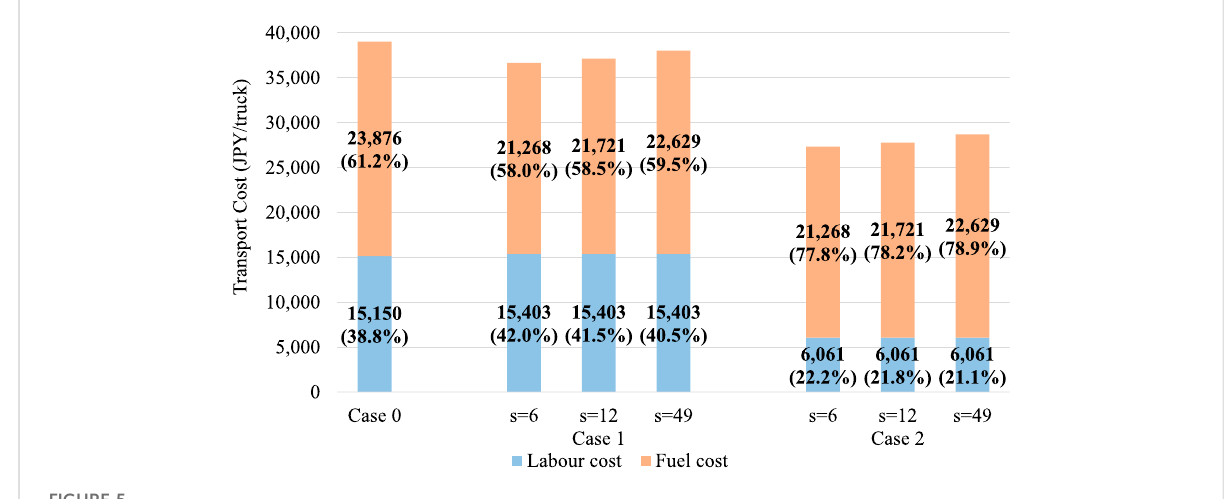
FIGURE 5 Breakdown of cost components for each inter-vehicle distance and operation case when n = 3, D = 800 and t f = 0.